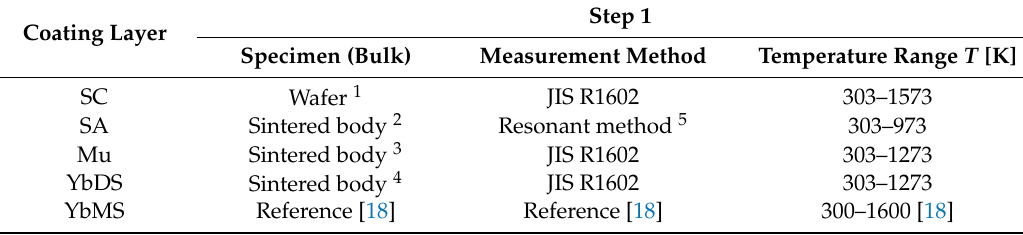
Table A1. Estimation procedure of E of SiC, SiAlON, mullite, YbDS and YbMS layers (Step 1). Coating